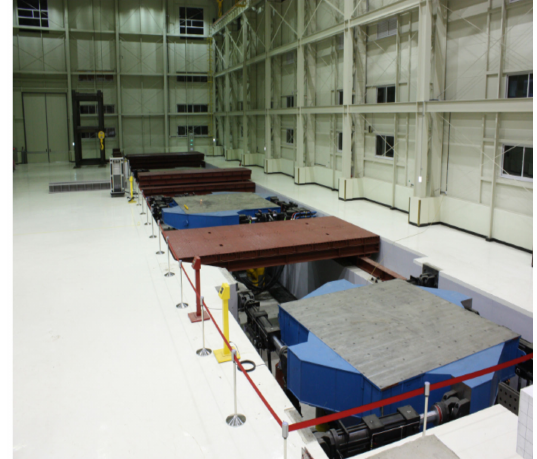
Figure 9. A shaking